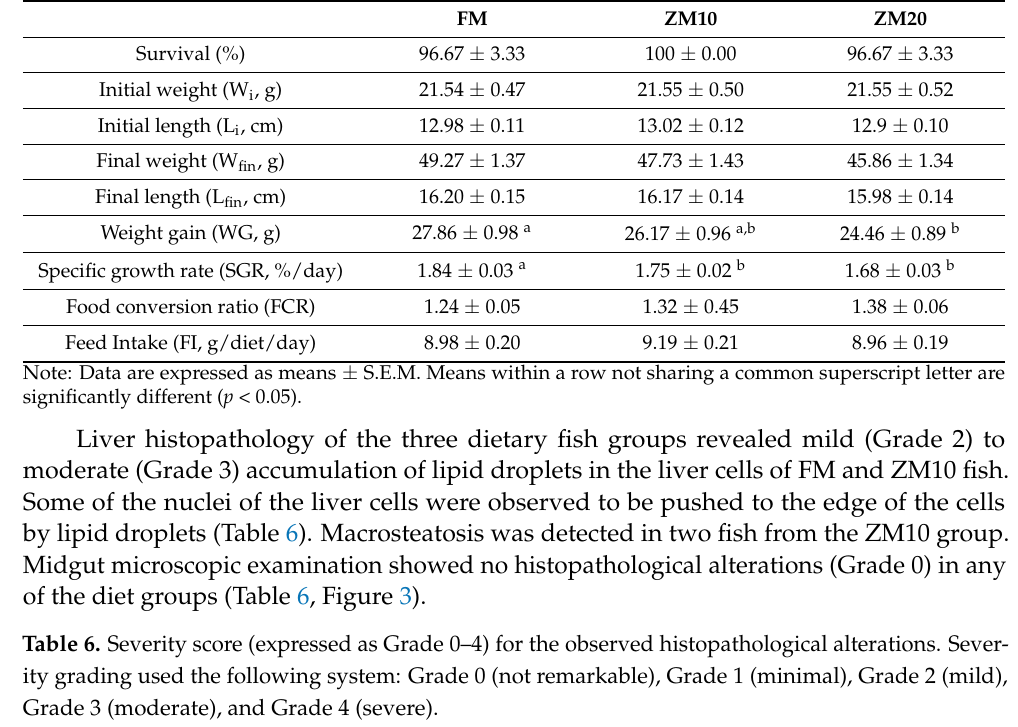
Table 5. Growth performance of sea bass that were fed the three experimental diets for 45 days.